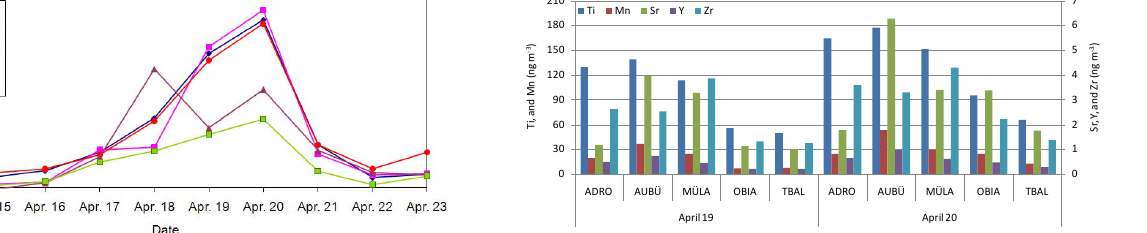
Fig. 8. Concentrations of Titanium in ambient PM 10 samples at five L ¨UB sites (see Fig. 1 also: Andechs/Rothenfeld (ADRO), Augsburg (B¨urgermeister-Ulrich-Strasse) (AUB ¨U), M¨unchen (Landshuter Allee) (M ¨ULA), Oberaudorf (Inn valley motorway) (OBIA), Tiefenbach/Altenschneeberg (TBAL)) from 14 April to 23 April. This variation corresponds with the spatial distribution of PM 10 concentrations on 19 April and 20 April as shown in Fig. 5.